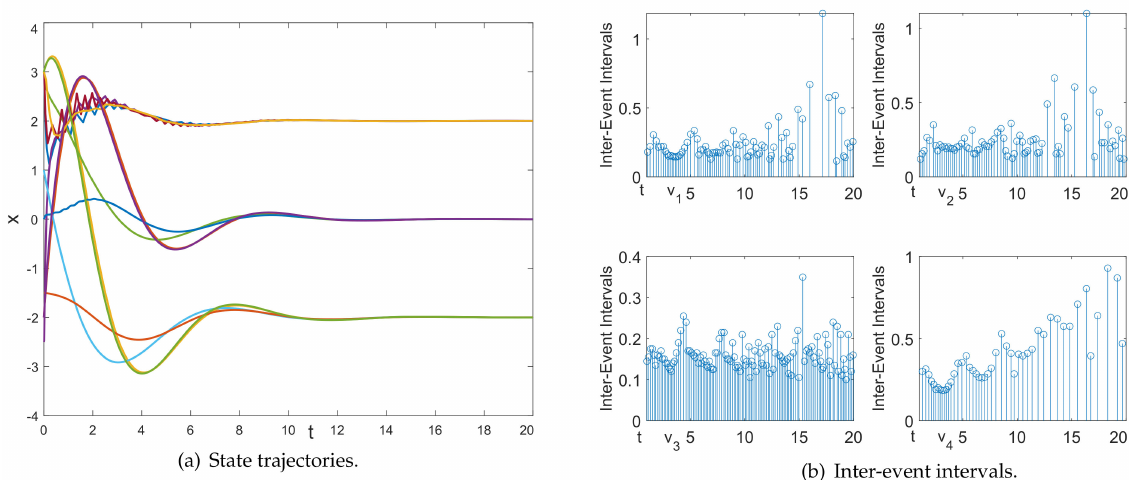
Figure 3. Integral–type edge-event-triggered policy in (5).